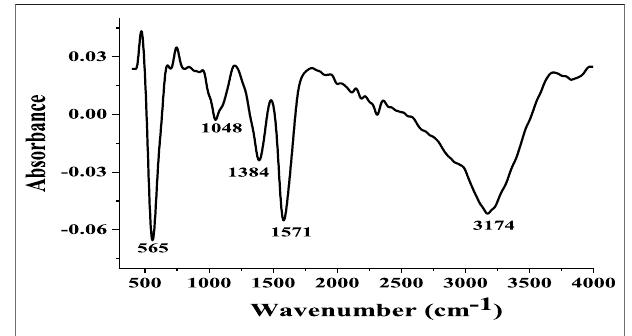
FIGURE 2 | FT-IR spectrum of Fe 3 O 4